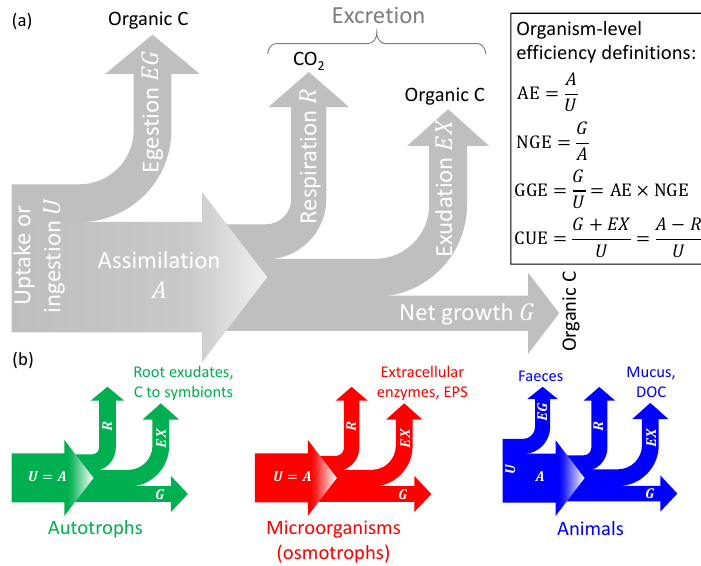
Figure 1. General conceptual summary of C exchanges of individual organisms (or populations). (a) General terminology and C-based efficiency definitions (Sterner and Elser, 2002). (b) C exchanges of autotrophs, microorganisms feeding through the cell membranes (os- motrophs), and animals; note that assimilation is equal to uptake (or ingestion) in autotrophs and osmotrophs that lack guts so that egestion cannot occur. The type of excretion product is also indicated (EPS: extracellular polysaccharides). Colour codes for the different organisms are also used in other